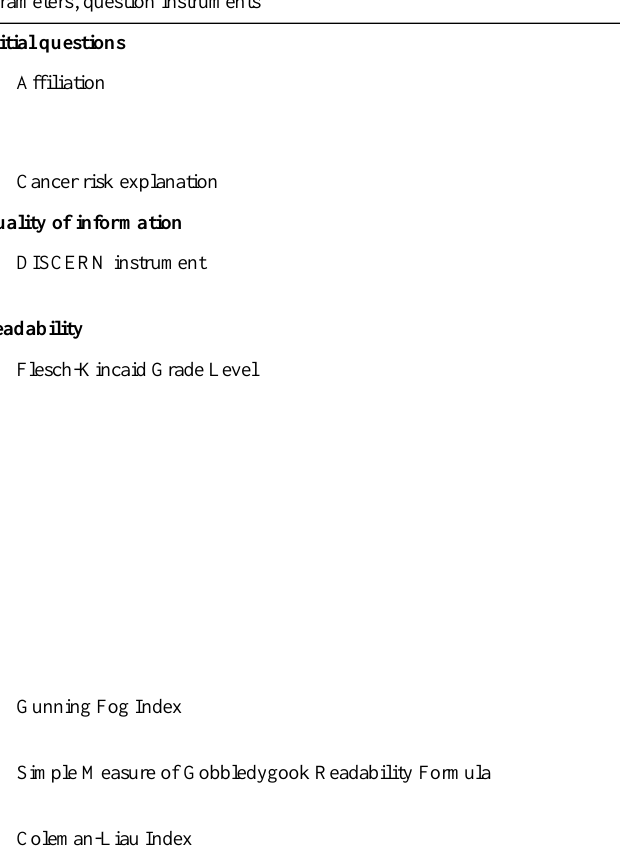
Table 1. Measuring instruments used for health information websites. DescriptionParameters, question